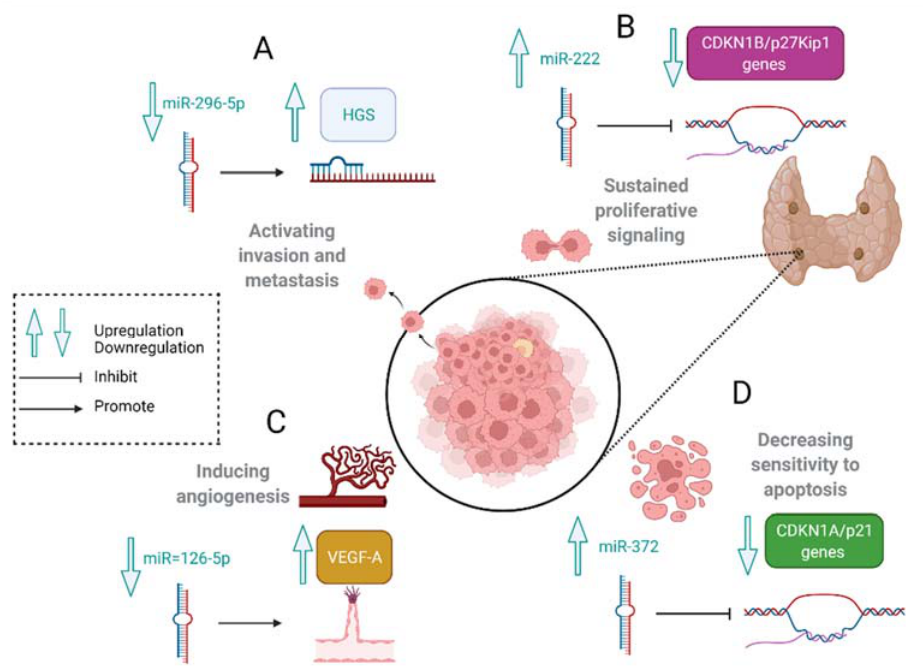
Figure 1. The mechanisms of roles of selected miRNAs involved in parathyroid tumorigenesis. ( A ). MiR-296 negatively correlates with HGS mRNA expression levels. HGS overexpression leads to tumor cell invasiveness and metastasis according to the downregulation of E-cadherin. ( B ). MiR-222 inhibits CDKN1B/p27Kip1 involved in cell cycle regulation. ( C ). The downregulation of miR-126-5p induces angiogenesis via VEGF. ( D ). MiR-372 inhibits CDKN1A/p21 genes and decreases parathyroid cells’ sensitivity to apoptosis. Created with BioRender.com (accessed on 1 February 2022).